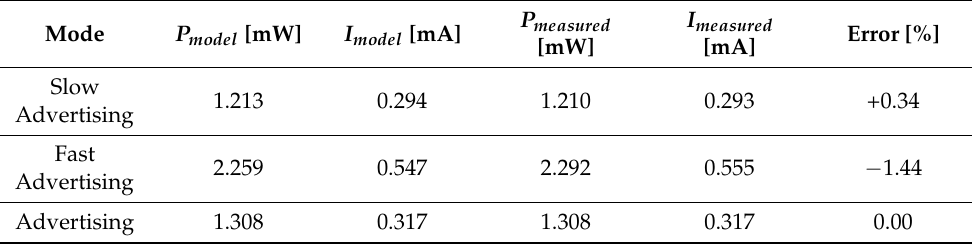
Table 3. Comparison of measured and model-based power and current consumption for idle mode. Model error is presented as percentage of the measured value.